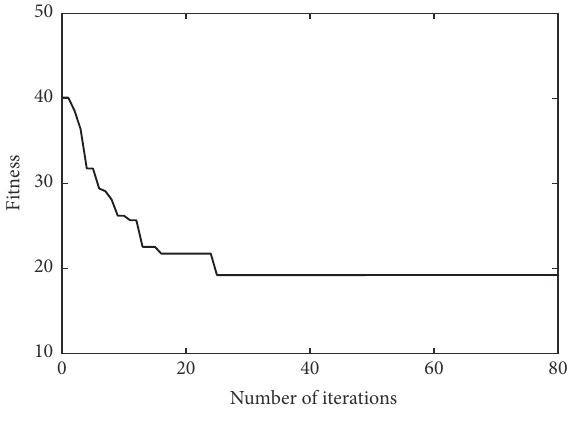
Figure 12: Fitness curve of optimization.